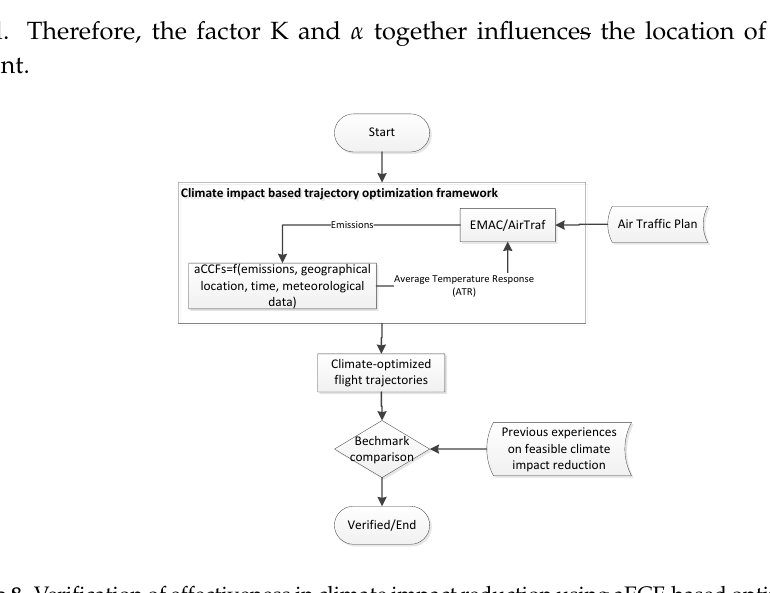
Figure 8. Verification of effectiveness in climate impact reduction using aECF-based optimised